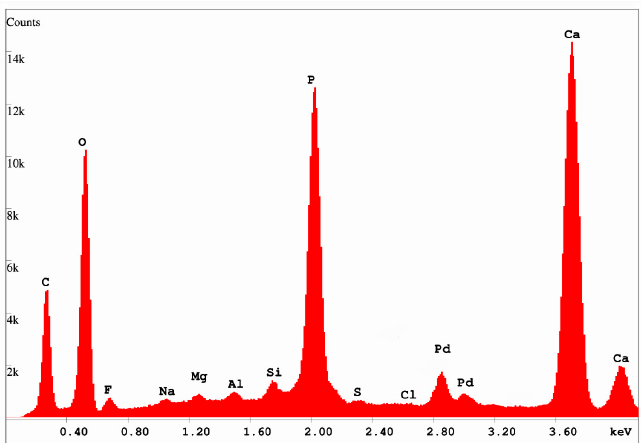
Figure 10. SEM/EDS spectrum, 15 KeV. Pd peaks are spectral artifacts from sputter-coating the specimen with Pd to provide electrical conductivity. Calculated fluorine content = 1.03 wt. % (= 1.11 atomic %); chlorine content = 0.0 wt. % (= 0.0 atomic %). Table 1. Major element analysis by X-Ray Fluorescence Spectrometry. Elemental results are calculated as wt. % oxide.